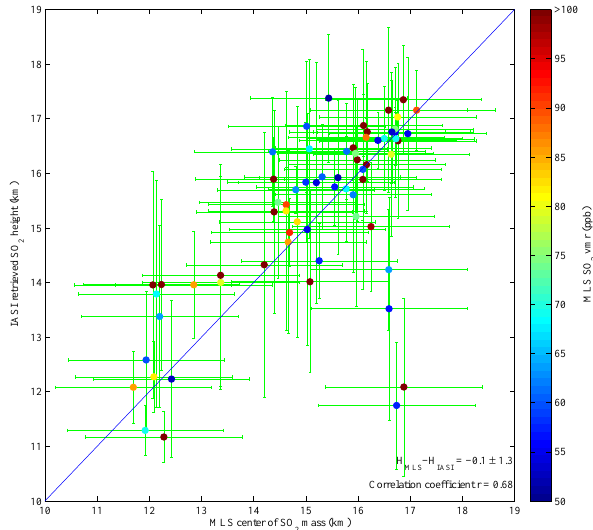
Fig. 11. Comparison of MLS centre of SO 2 mass with coincident IASI SO 2 height retrievals in a 200km radius around the MLS mea- surements. The MLS errorbar was taken fixed at ± 1.5km, the IASI errorbar depicts the standard deviation of the coincident IASI mea- surements. MLS data is from the v3.3 EOS MLS Level2 which was downloaded from the NASA Goddard Space Flight Center, Data and Information Services Center